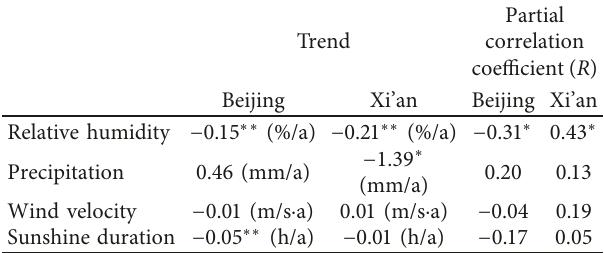
Table 1: The trend of potential influencing factors and their partial correlation with the start of LCS.